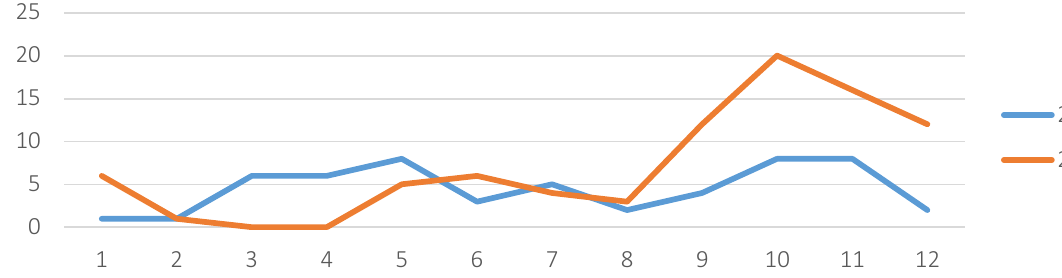
Figure 7. Monthly distribution of the number of brokerage events in which Ukrainian participants took part in 2019 and 2020 according to the EEN event